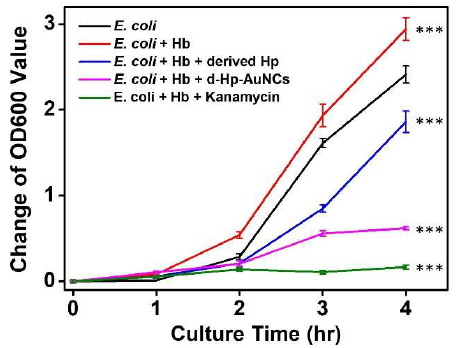
Figure 4. Growth curves of Escherichia coli incubated with various solutions, including (i) E. coli, (ii) E. coli + hemoglobin (Hb), (iii) E. coli + Hb + kanamycin, (iv) E. coli + Hb + derived haptoglobin (d-Hp), and (v) E. coli + Hb + d-Hp-gold nanoclusters (AuNCs). The results are presented as the mean ± SD of n = 4 independent experiments. Asterisks indicate significant differences (*** p < 0.001). *** p < 0.001 compared to E. coli